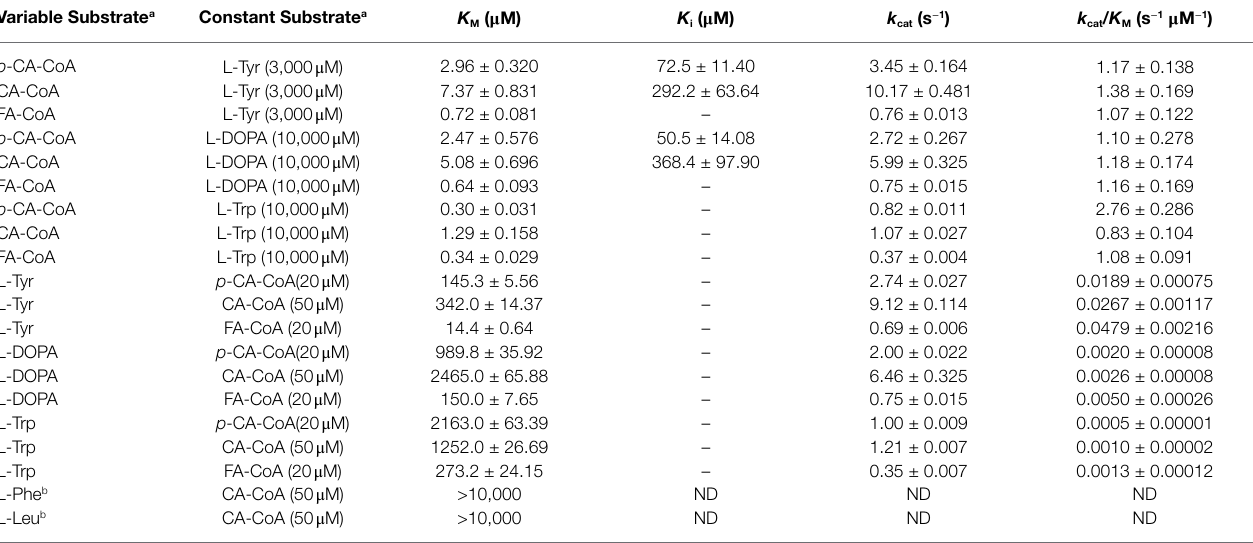
TABLE 7 | Kinetic parameters for red clover